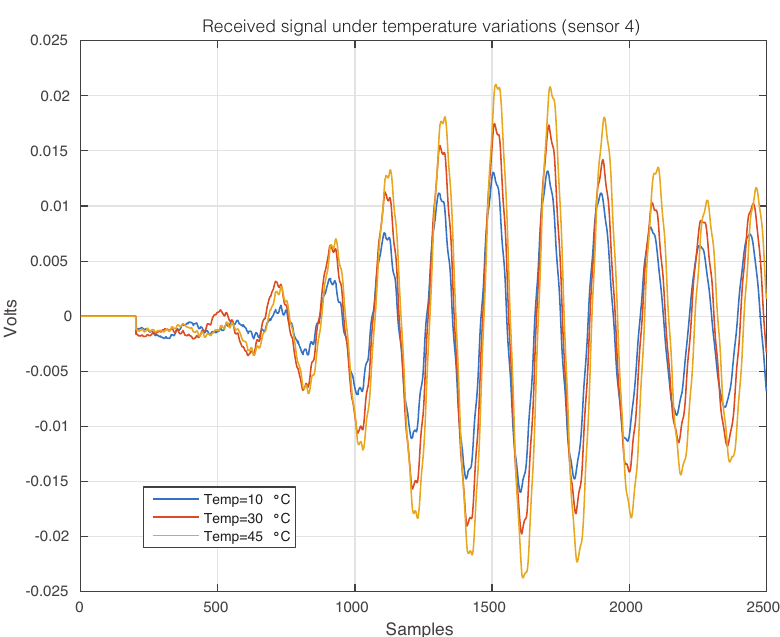
Figure 13. Signal that is received by Sensor 4 when the first sensor is used as an